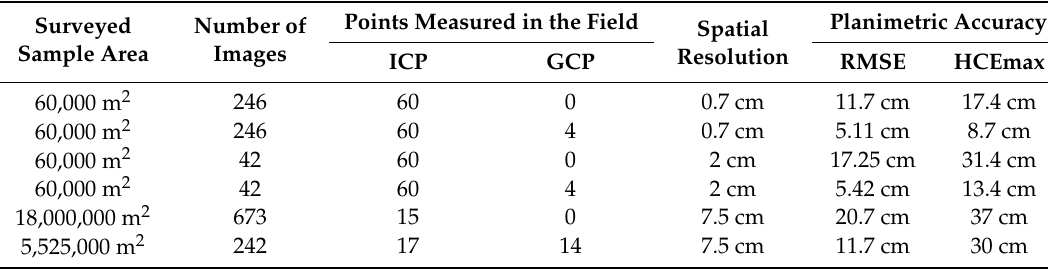
Table 4. Geometric accuracy tested on grassland and urban areas. ICPs: number of independent checkpoints, GCPs: number of ground control points, RMSE: planimetric root mean square error, HCEmax: maximum horizontal circular error (distance between ICP and its image